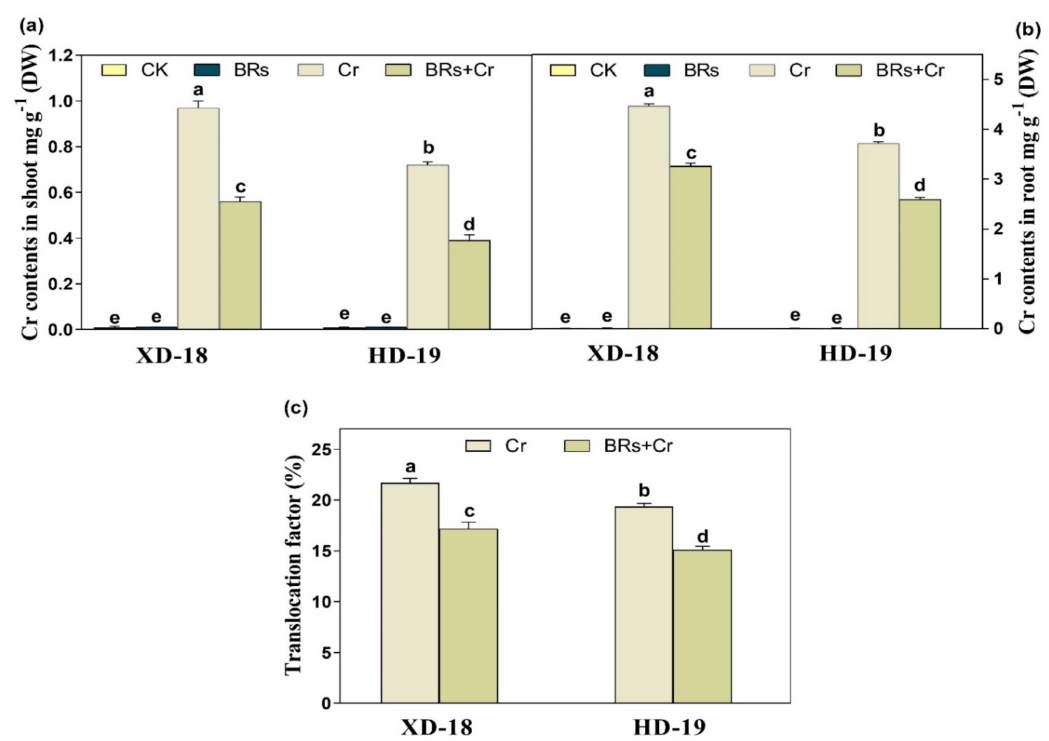
Figure 3. Effect of foliar applied BRs (0.01 µ M) on Cr contents, and translocation factor in tissues of two soybean genotypes (XD-18 and HD-19) under chromium (Cr) (0 and 100 µ M) stress. ( a , b ) Cr contents in shoots, and roots; ( c ) Translocation factor. Values are the means ± SD of four independent replicates. Different alphabetical letters on bars indicate significant differences among the treatments ( p < 0.05) by the least significant difference test. Table 2. Effect of foliar-applied BRs on the accumulation of endogenous calcium (Ca), magnesium (Mg), manganese (Mn), zinc (Zn), and copper (Cu) ions in the shoots, and roots of two soybean cultivars (XD-18 and HD-19) under Cr